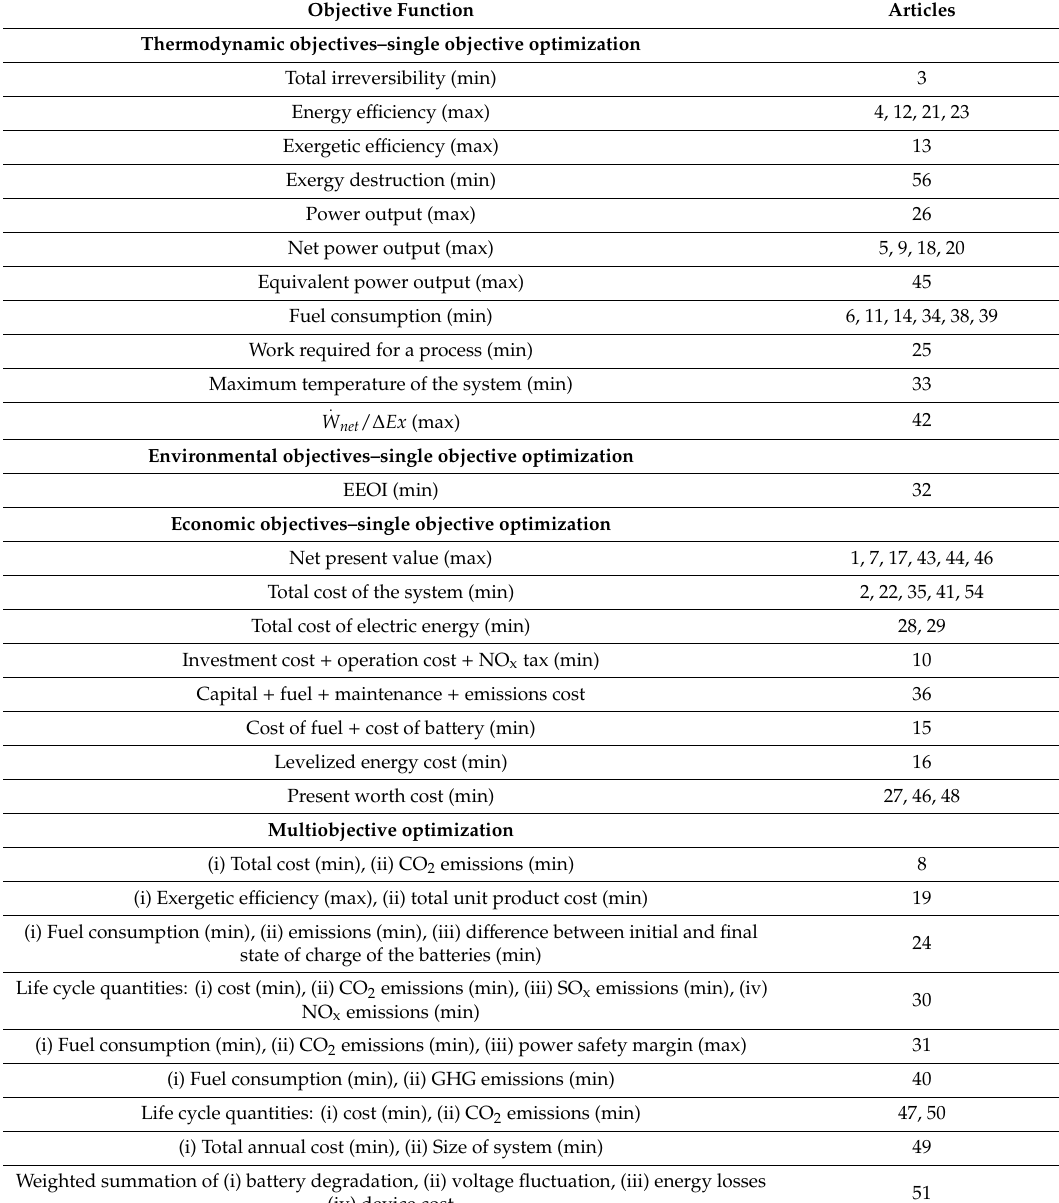
Table 4. Objective functions and articles. (The numbers are those written in the first column of Table 1. Explanations of symbols and abbreviations are written after Section 7